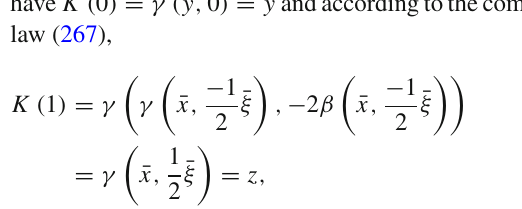
Fig. 1 The middle point and tangent